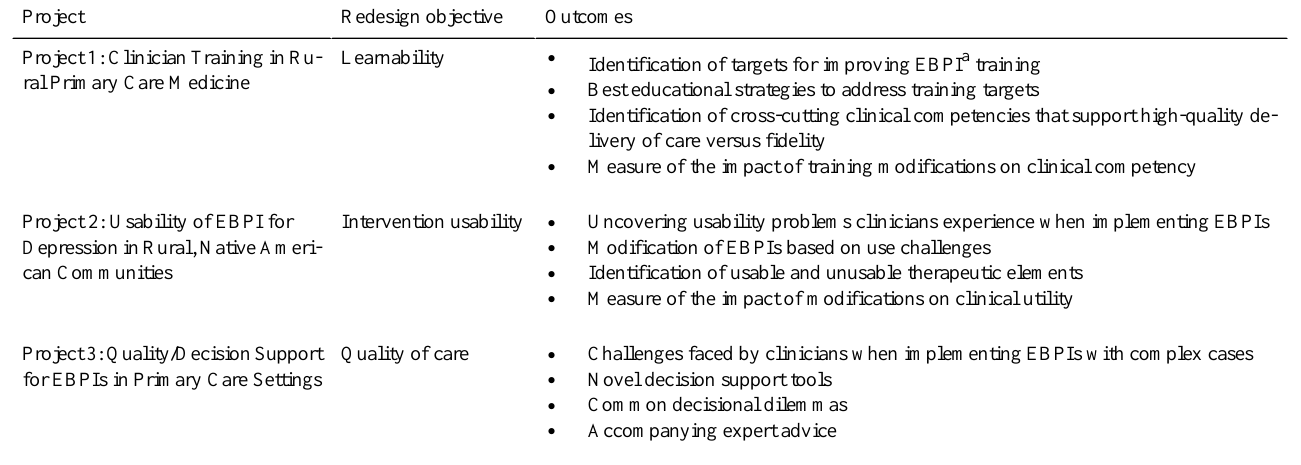
Table 1. Center project objectives and outcomes.